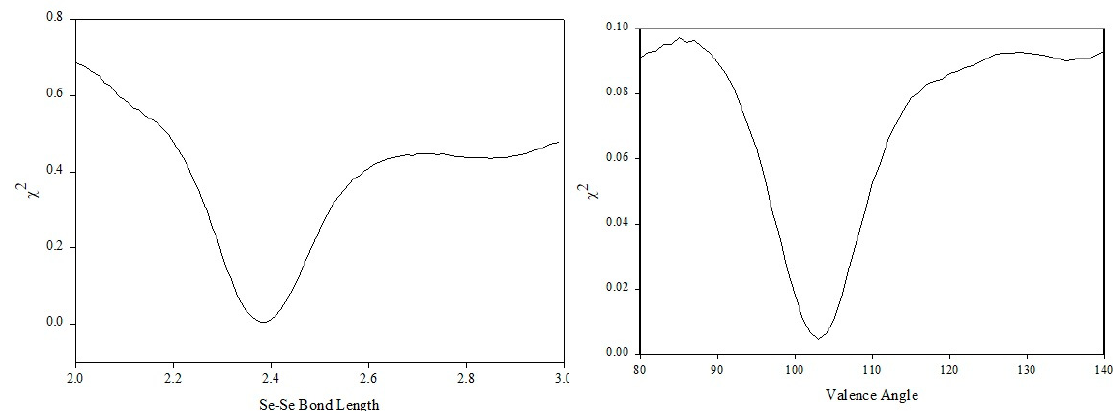
Figure 10. χ 2 test results for the selenium bond length (left) and valence angle (right).